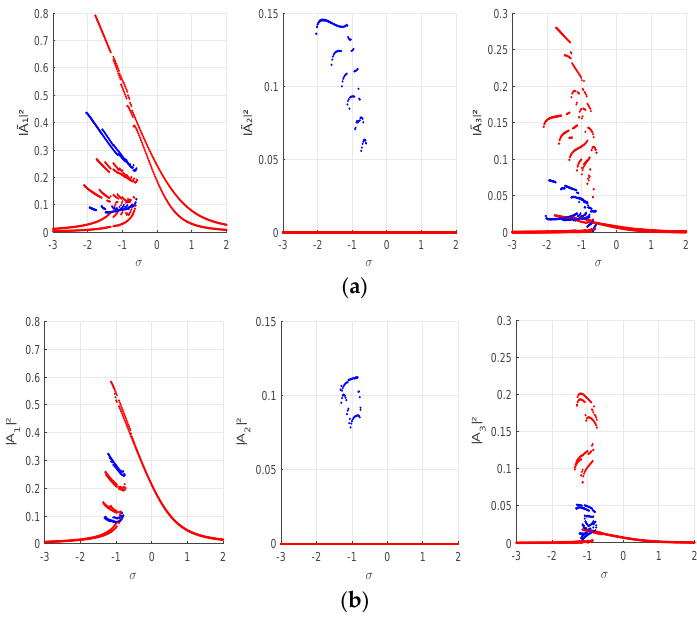
Figure 14. Envelopes of the modal intensity amplitude responses: ( a ) (cid:3627)(cid:1827)(cid:4634) (cid:2869) (cid:3627) first pendulum and ( b ) |(cid:1827) (cid:2869) | (cid:2870) , |(cid:1827) (cid:2870) | (cid:2870) and |(cid:1827) (cid:2871) | (cid:2870) of the second pendulum, computed using the gPCE method for (cid:2012) (cid:3039) = 5% .